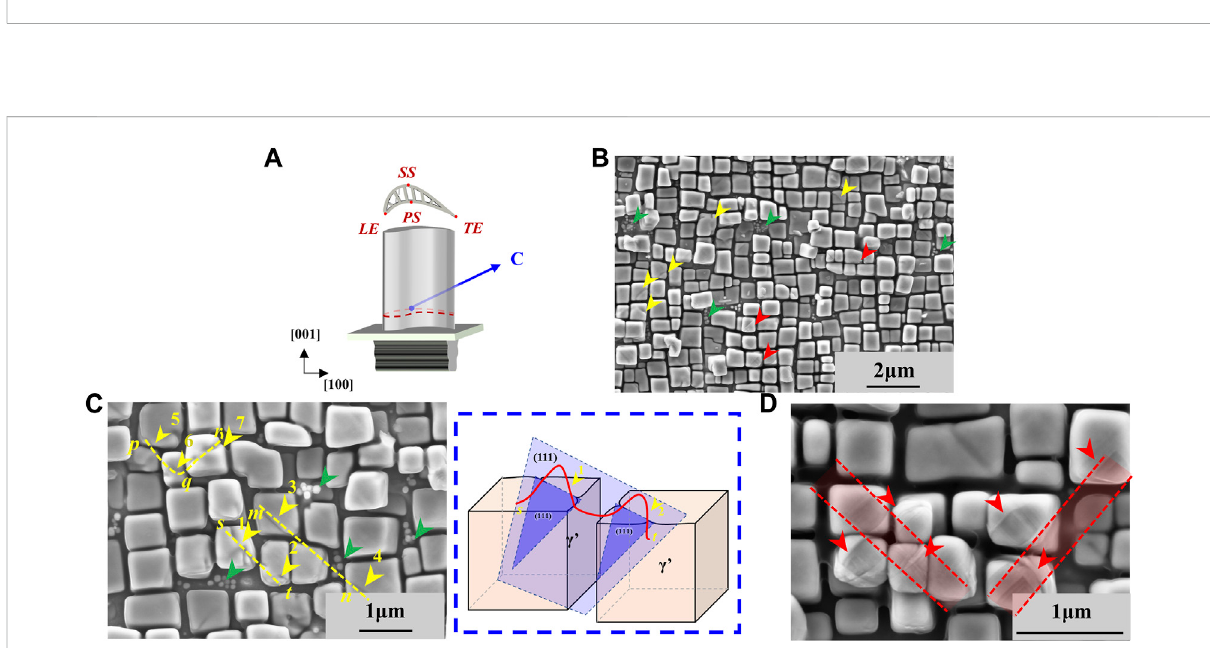
FIGURE 4 SEM morphologies of defects at point C of the blade: (A) the position of point C on the blade, (B) various defects on the surface of the γ ′ precipitatesatpointC, (C) dislocationscutintothe γ ′ precipitatesandaschematicdiagramofdislocationbehavior, (D) otherfeatureonthesurfaceof the γ ′